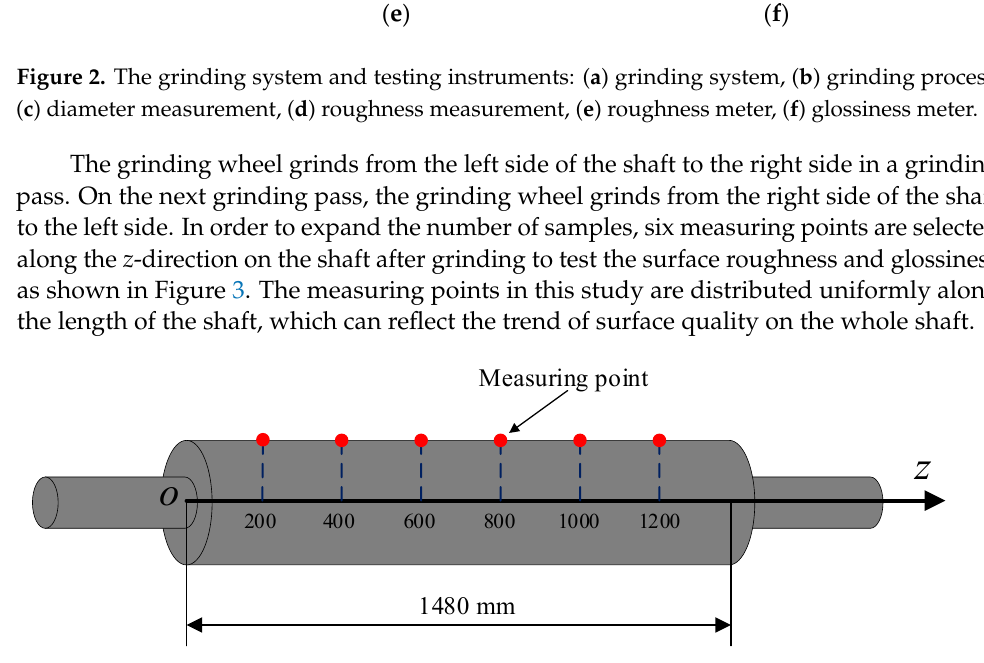
( d ) Figure 4. The influence of three grinding parameters on surface roughness and glossiness: ( a ) grinding depth, ( b ) shaft speed, ( c ) pallet speed, ( d ) grinding wheel speed. For grinding wheel speed, lower surface roughness values and higher glossiness val ‐ ues are obtained in the range from 700 to 850 r/min. The spindle current standard devia ‐ tions of the grinding passes in Figure 5d are shown in Table 2. It can be seen that the